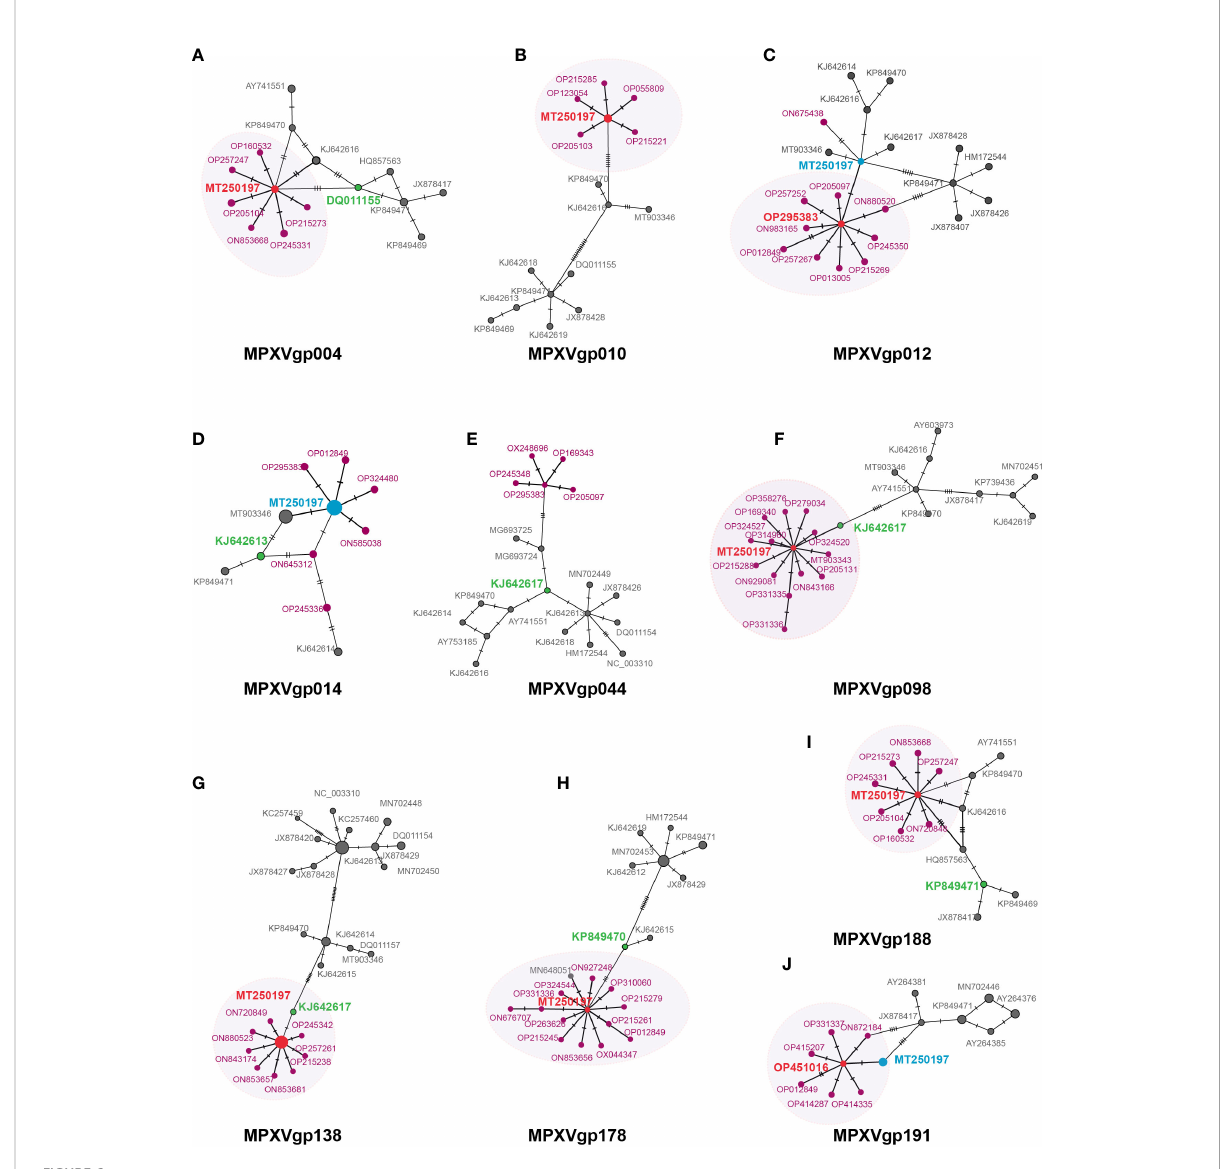
FIGURE 6 Minimum spanning network of MPXV genes under positive selection at the codon level. Those genes that were identi fi ed as positively selected genes including (A) MPXVgp004, (B) MPXVgp010, (C) MPXVgp012, (D) MPXVgp014, (E) MPXVgp044, (F) MPXVgp098, (G) MPXVgp138, (H) MPXVgp178, (I) . MPXVgp188, and (J) MPXVgp191 are shown. Haplotype (allele) diversity was obtained from about 1,500 MPXV isolates worldwide. Each oblique line linking between alleles (allele name is shown as its representative isolate NCBI accession numbers) represents one mutational difference. The ancestral allele, or root of the network, is labeled with red, and the represented allele name is marked red. The dark red nodes indicate alleles that arose in the 2022 outbreak isolates. The oval box with a light shadow shows the star structure of the MSNs. For MPXVgp014, MPXVgp138, MPXVgp178, and MPXVgp191, some alleles were identi fi ed as the same by popART, which removes the gaps of the alignment, and these alleles show as larger circles. For those alleles, MT250197 is not shown as an obvious center of the star structure and is marked light blue. Those alleles that have positive selection mutations that fi rst arose about 40 to 50 years ago are marked